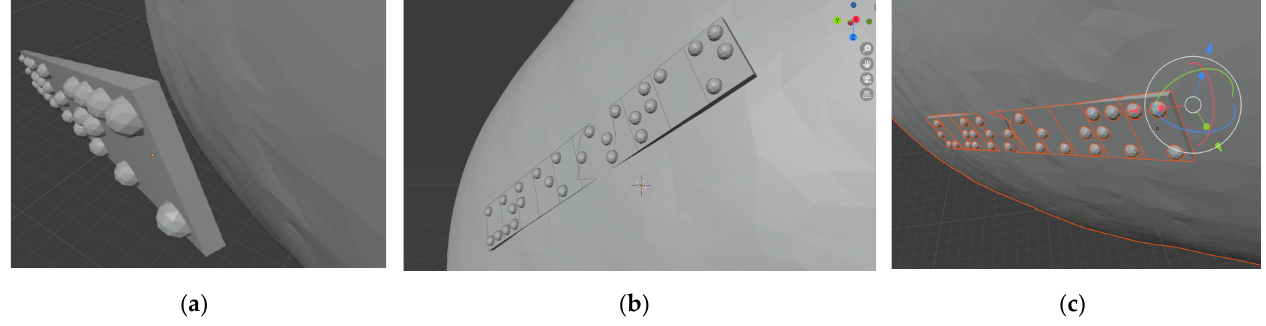
Figure 9. Preview of inserting inscriptions into the surface of the object in Blender—Stage D: ( a ) placing the inscription above the surface, ( b ) introducing the inscription into the surface of the object, ( c ) merging the objects into a whole—Stage E.